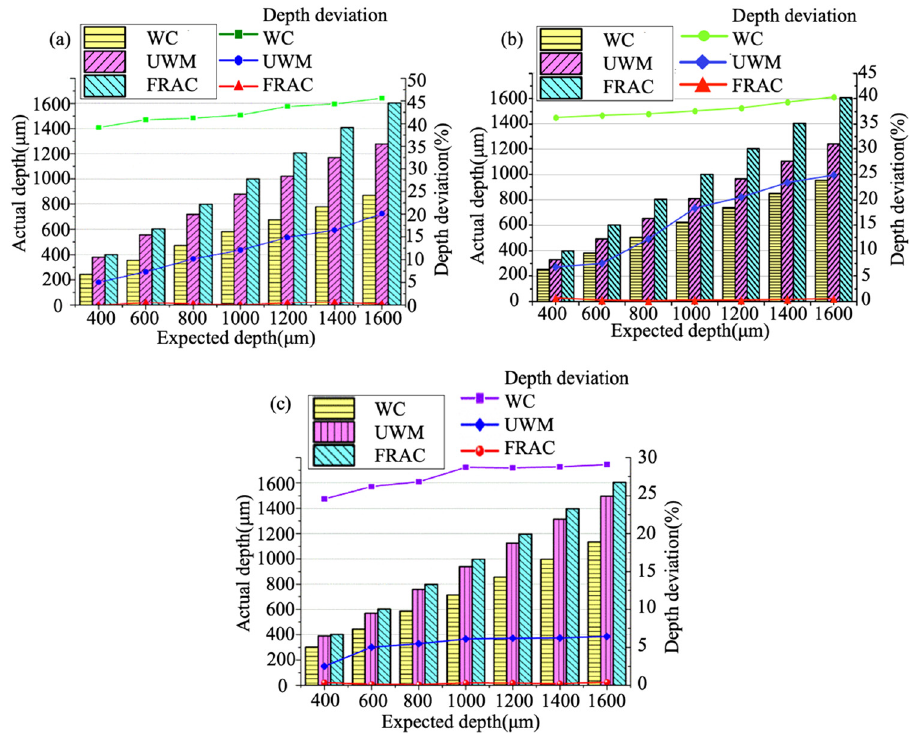
Figure 4: The measurement depth and depth deviation of blind holes: ( a ) tungsten steel electrode, ( b ) brass electrode, and ( c ) copper electrode ( frequency = 130 kHz, pulse width = 5 µs, current = 4.5, voltage = 90 V, gain coe ffi cient = 30 )